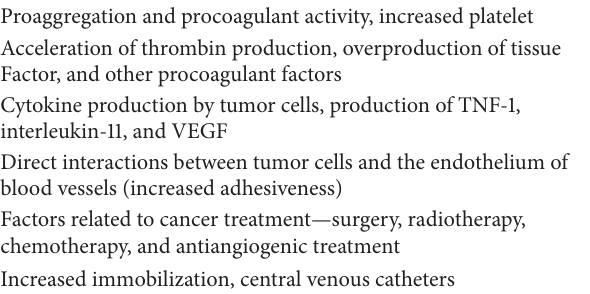
Table 1: Prothrombotic mechanisms in tumors. Proaggregation and procoagulant activity, increased platelet Acceleration of thrombin production, overproduction of tissue Factor, and other procoagulant factors Cytokine production by tumor cells, production of TNF-1, interleukin-11, and VEGF Direct interactions between tumor cells and the endothelium of blood vessels (increased adhesiveness) Factors related to cancer treatment—surgery, radiotherapy, chemotherapy, and antiangiogenic treatment Increased immobilization, central venous